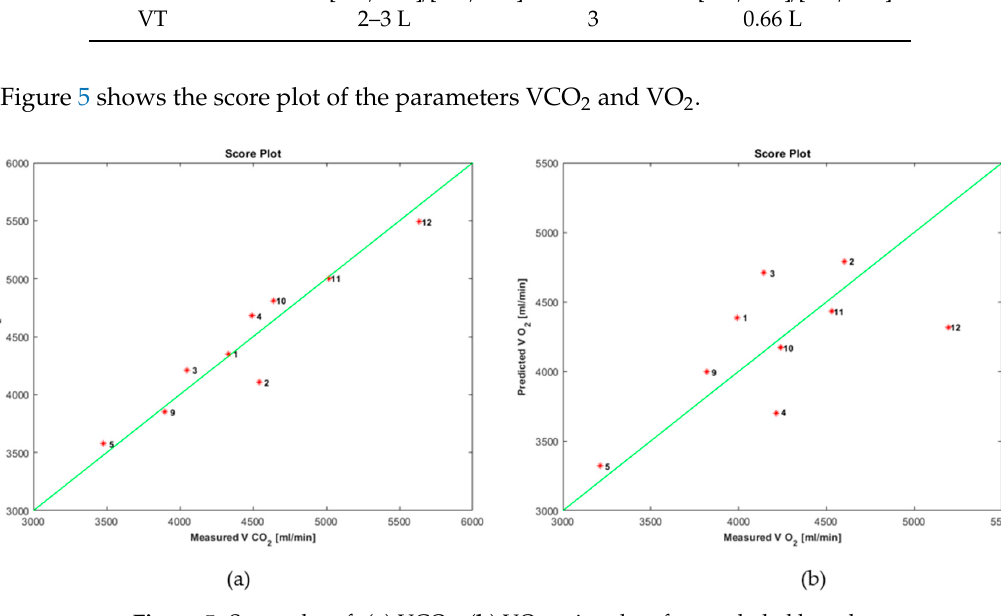
Table 2. Model parameters obtained from exhaled breath analysis.